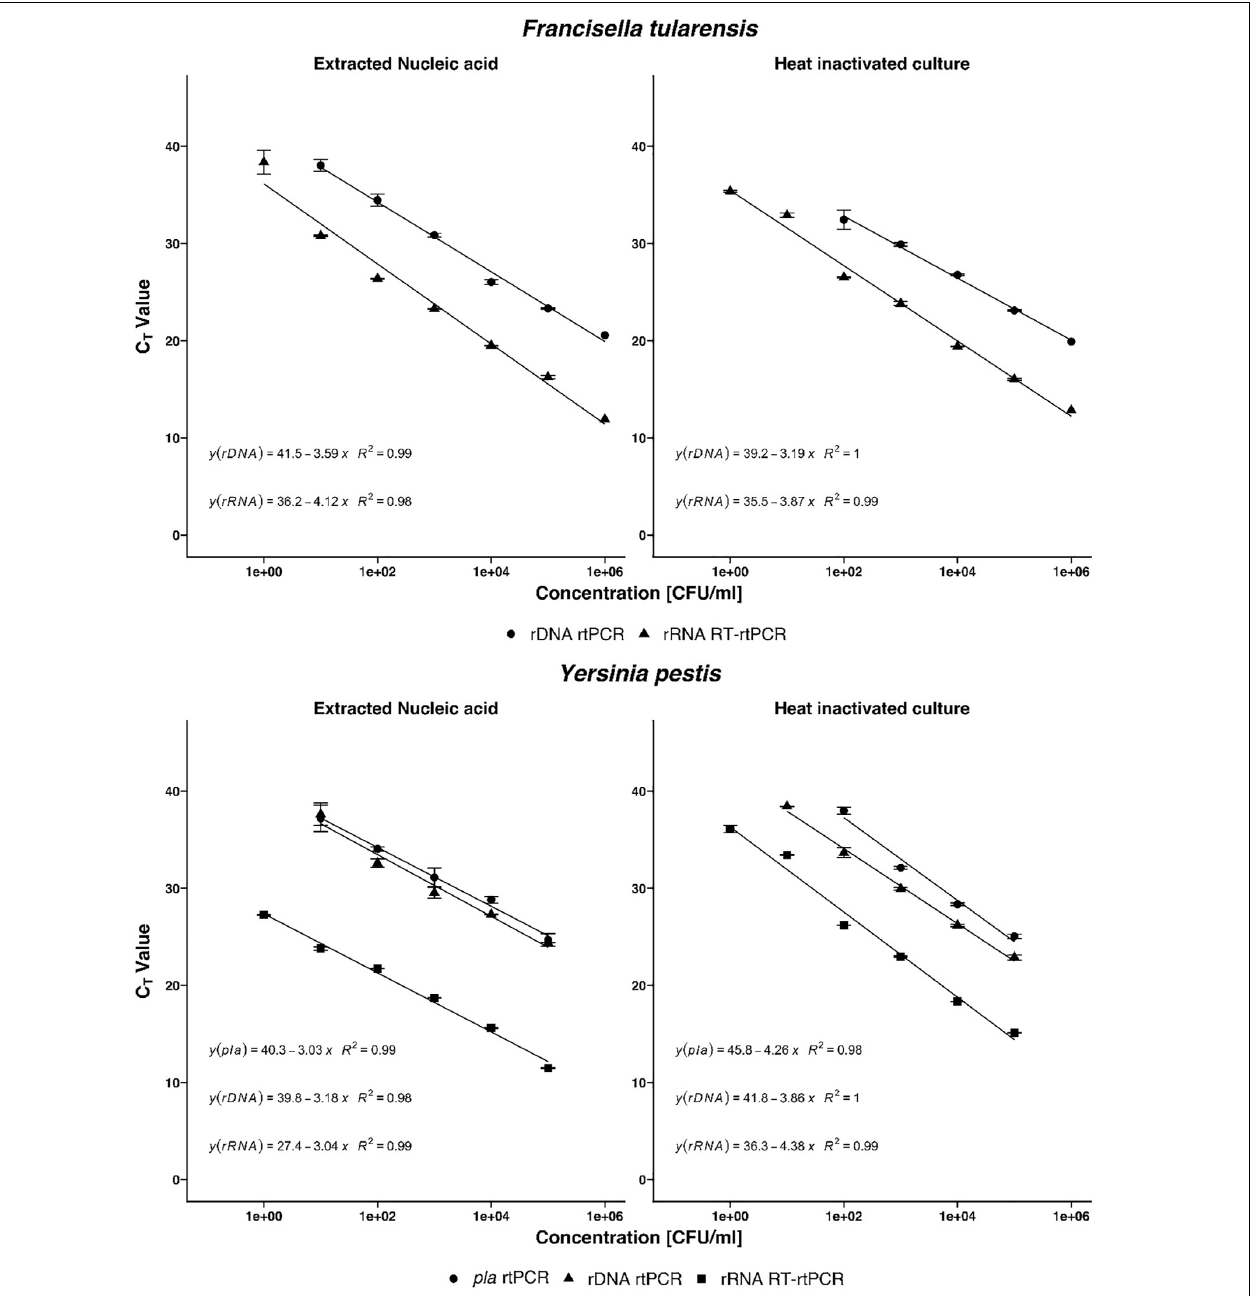
FIGURE 2 | Detection of Francisella tularensis and Yersinia pestis by real-time PCR (rtPCR) and reverse transcriptase (RT)-rtPCR. In a base-10 semi-logarithmic graph, the threshold cycle is plotted versus the concentration in colony-forming units per milliliter (CFU/ml) and the data are fitted to a straight line. Coefficient of determination ( R 2 ) is determined by linear regression analysis, indicated by the respective formula. Comparison of F. tularensis rDNA rtPCR and rRNA RT-rtPCR as well as Y. pestis pla rtPCR, rDNA rtPCR, and rRNA RT-rtPCR. Error bars represent the SD of three independent